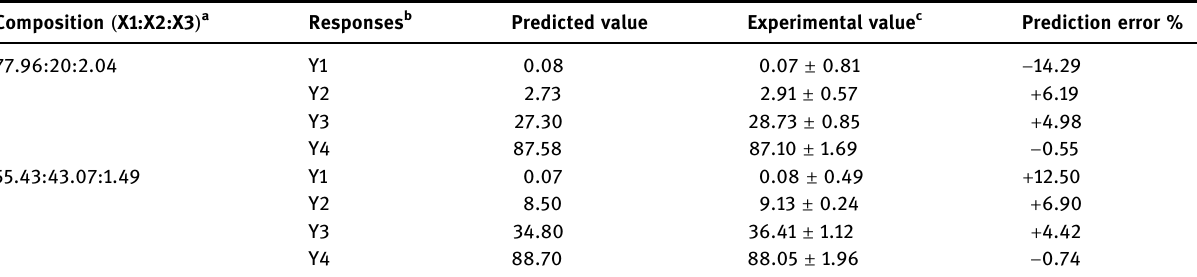
Table 5: Composition of the optimized formulations and comparison of experimental values of the response parameters with the predicted